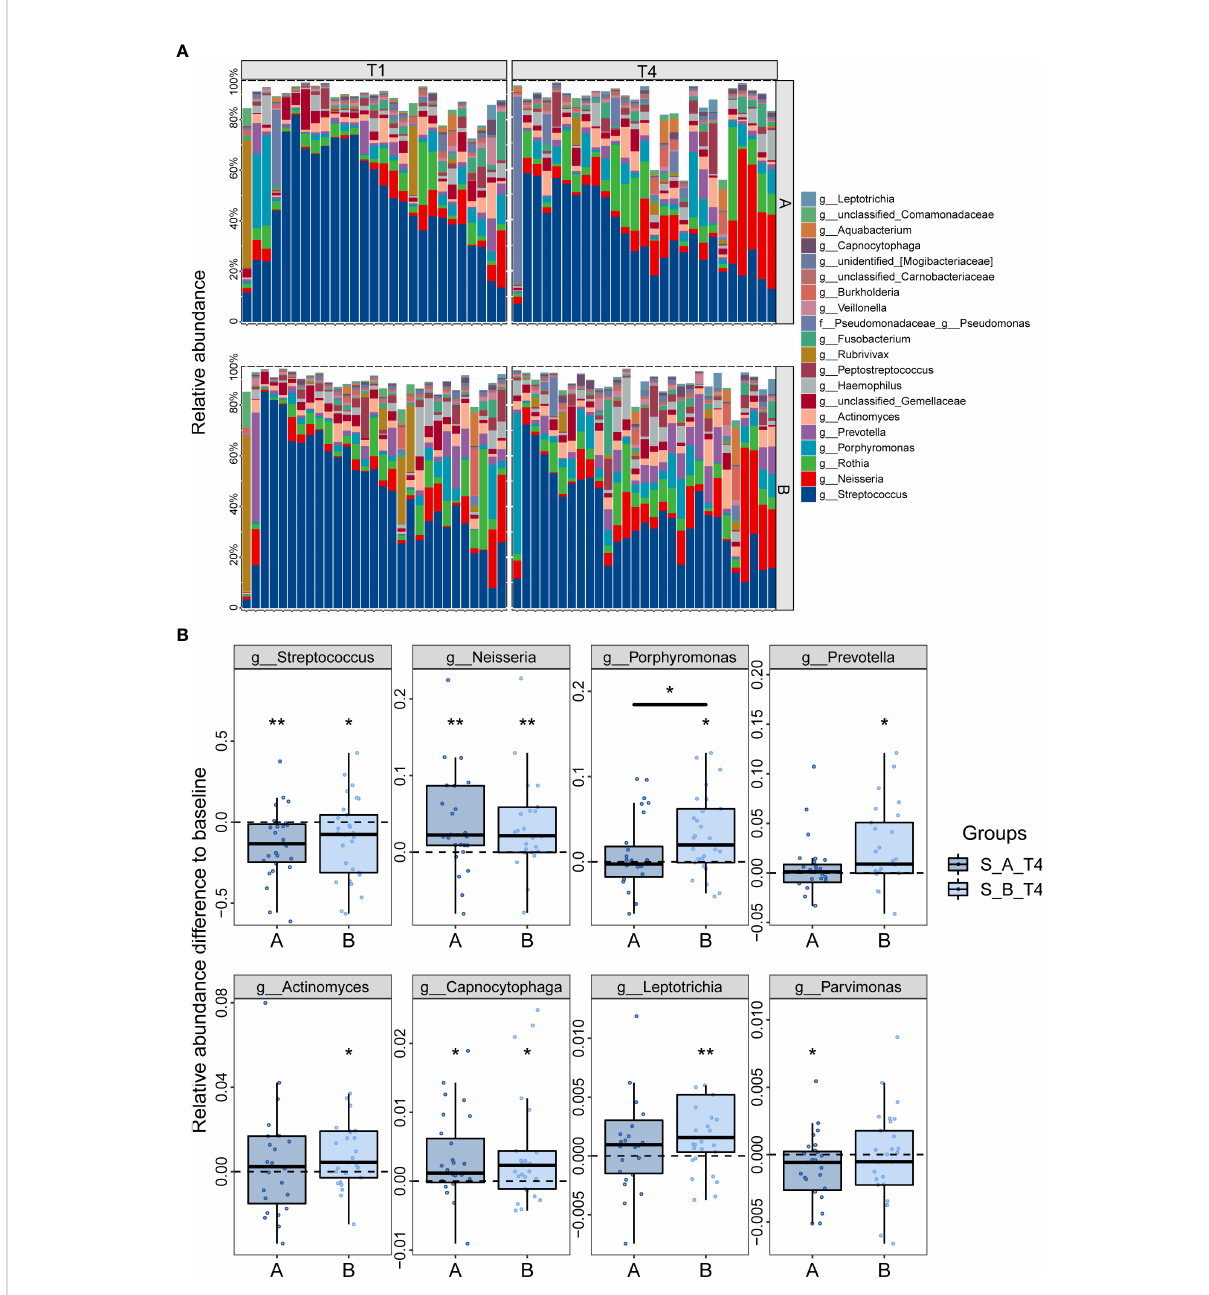
FIGURE 7 Effect of probiotics on saliva microbiota in patients following H. pylori eradication. (A) Compositional changes of the top 20 most abundant saliva genera. (B) Alterations of differential genera after H. pylori eradication. Values above zero represented the increased relative abundance at T4 relative to baseline, while those below zero represented decreased abundance. *p<0.05; **p<0.01; star without a line, comparison between T1 and T4; star with a line, comparison between (A, B) ; (A) probiotics group; (B) placebo